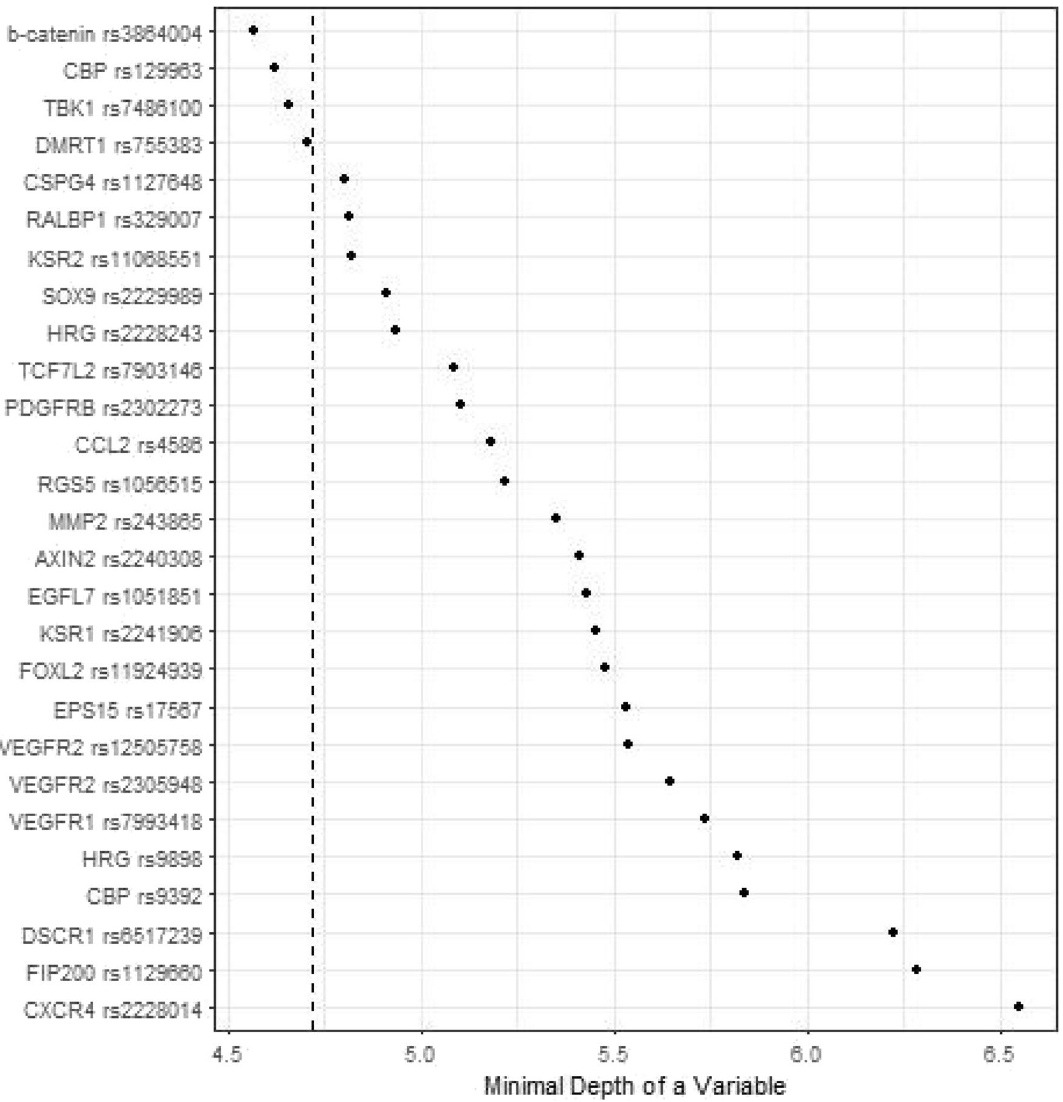
Figure 3. Minimal depth plot of 27 SNPs predicting PFS in KRAS mutant mCRC patients. The most predictive SNPs in order of importance are b-catenin rs3864004, CBP rs129963, TBK1 rs7486100, DMRT1